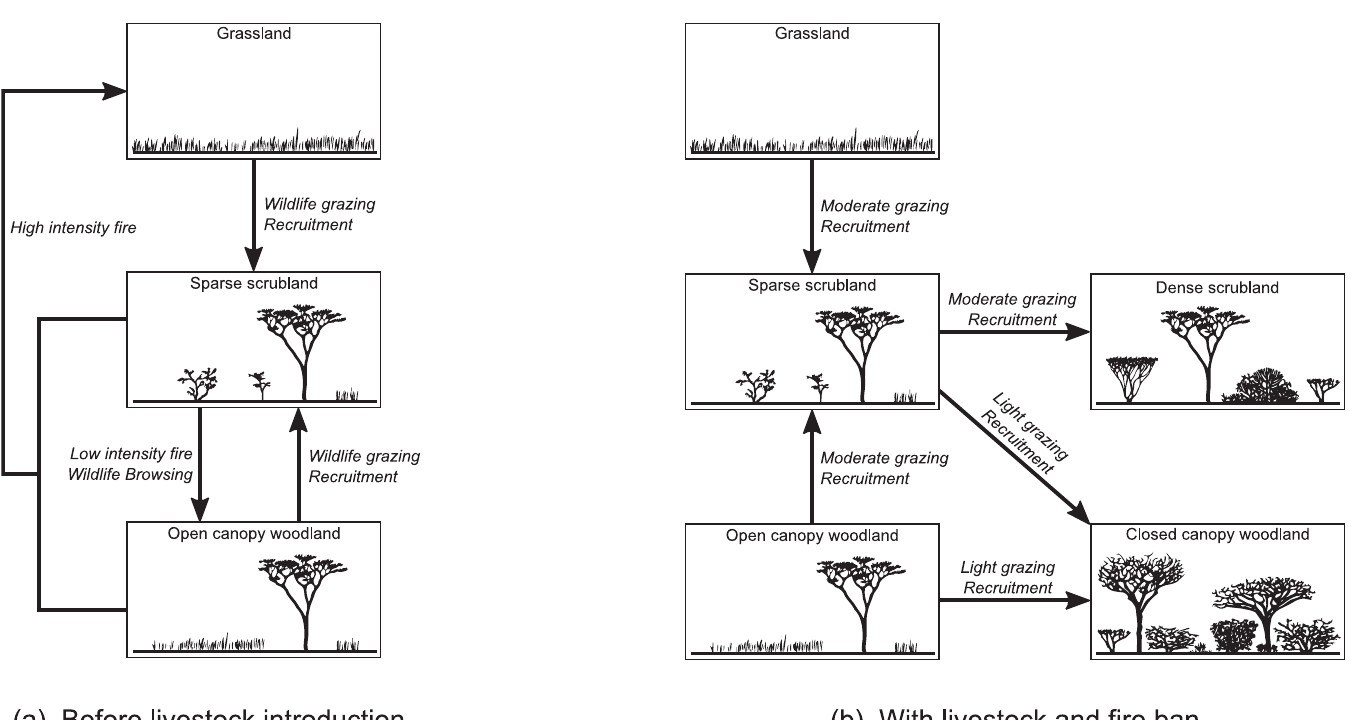
Fig 1. State-and-transition models of the Borana vegetation pathways. The states are embodied by illustrated boxes, and the transitions by arrows labelled by their main driving processes. (a) Before pastoralism, fire was the main driver of the rangeland dynamics. The combination of fire, wildlife herbivory and vegetation recruitment maintained the entire system in a loop between open canopy woodland and grassland. (b) The presence of cattle and the fire ban gave a competitive advantage to woody plants, inducing an irreversible bush encroachment. Concurrently, wildlife increasingly avoided the Borana zone because of the denser human and livestock populations. (Based on [21] with author’s